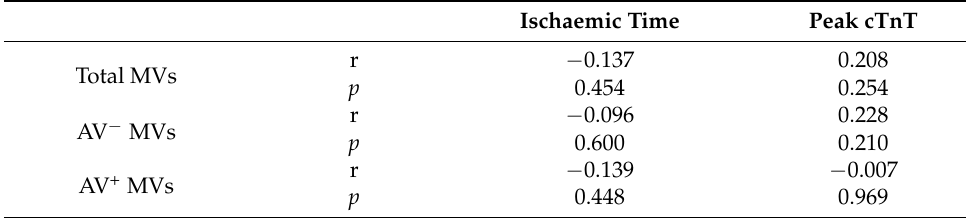
Table 5. Bivariate correlations between MVs, ischaemic time, and peak cTnT.